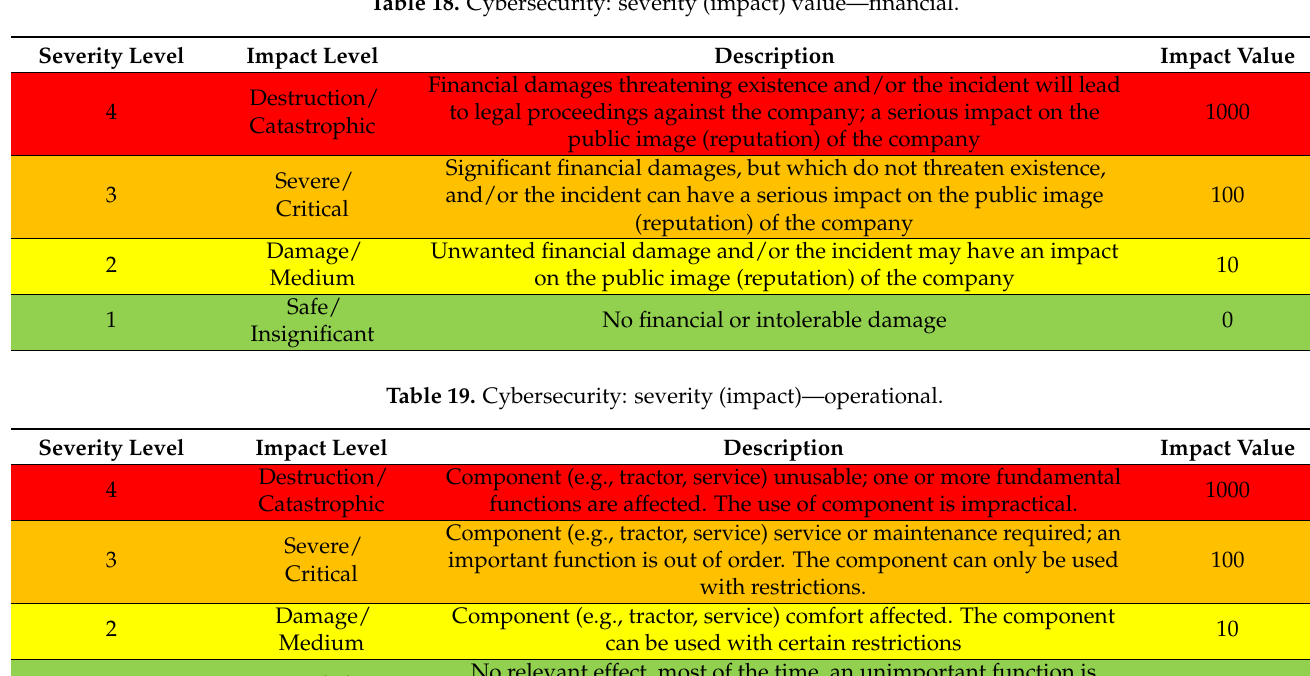
Table 18. Cybersecurity: severity (impact) value—financial.